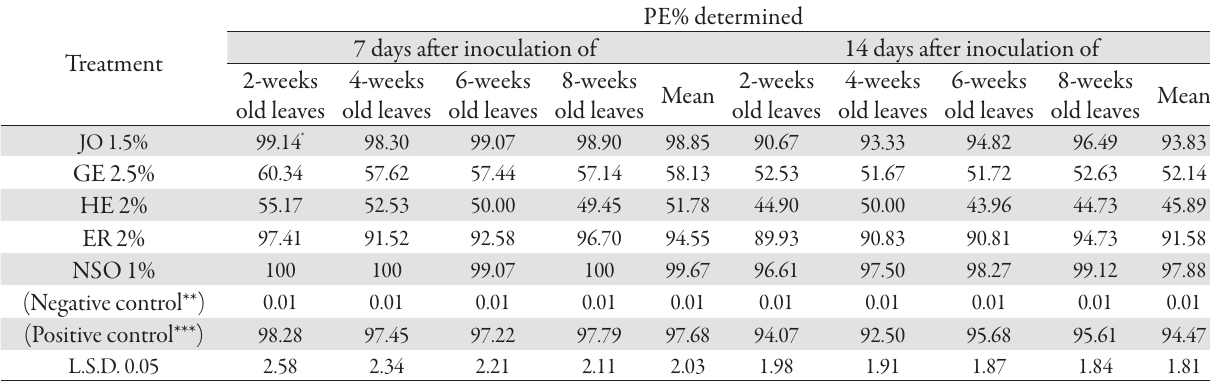
Tab. 3a. The preventative effect of tested plant derived agents against okra powdery mildew under artificial infection in greenhouse